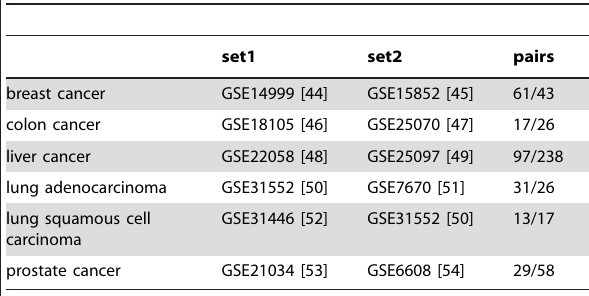
Table 1. A summary of the cancer datasets used in our transcriptomic data